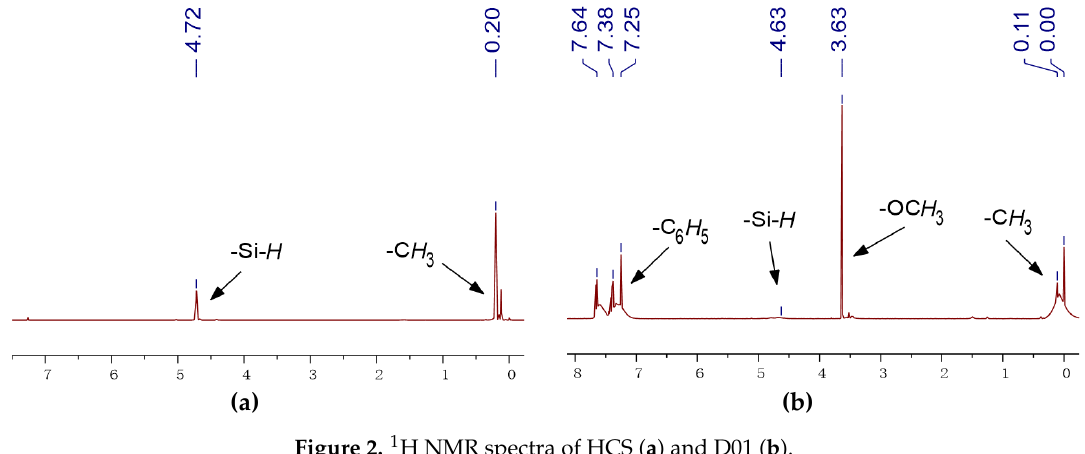
Figure 2. 1 H NMR spectra of HCS ( a ) and D01 ( b ).